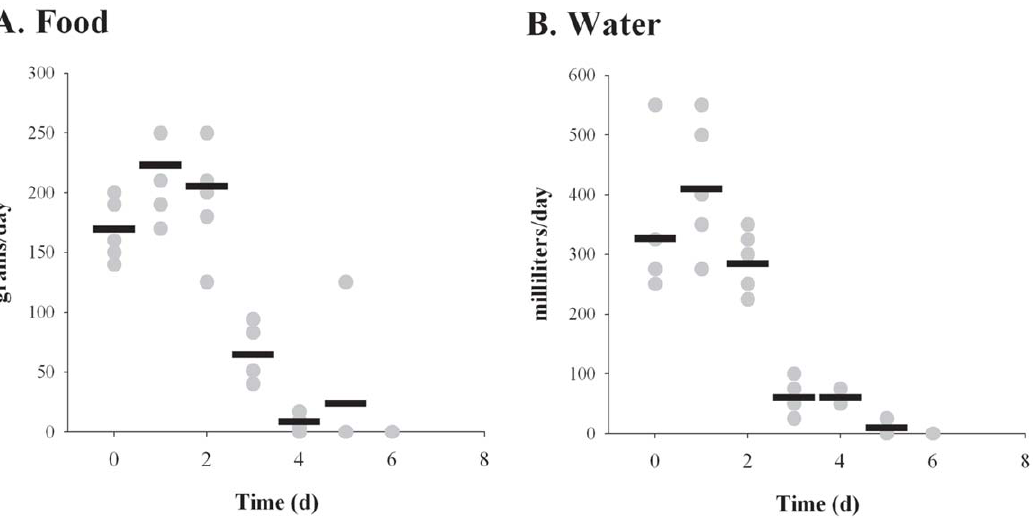
Figure 2. Rabbits reduce food and water intake after inhalation of F. tularensis. Food ( A ) and water ( B ) intake was measured daily for 6 NZW rabbits exposed to aerosolized SCHU S4. Graphs show values for individual rabbits (gray circles) and averaged data (black bars) for each day after exposure.